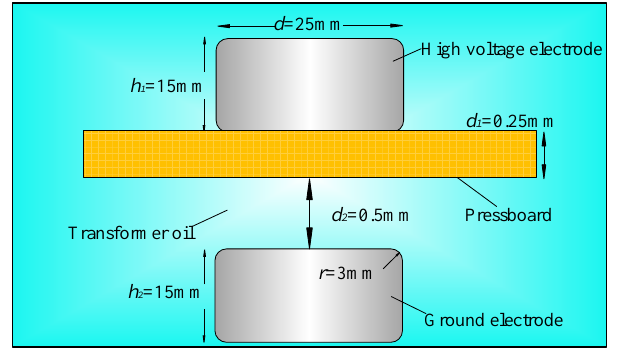
Figure 1. Test model.